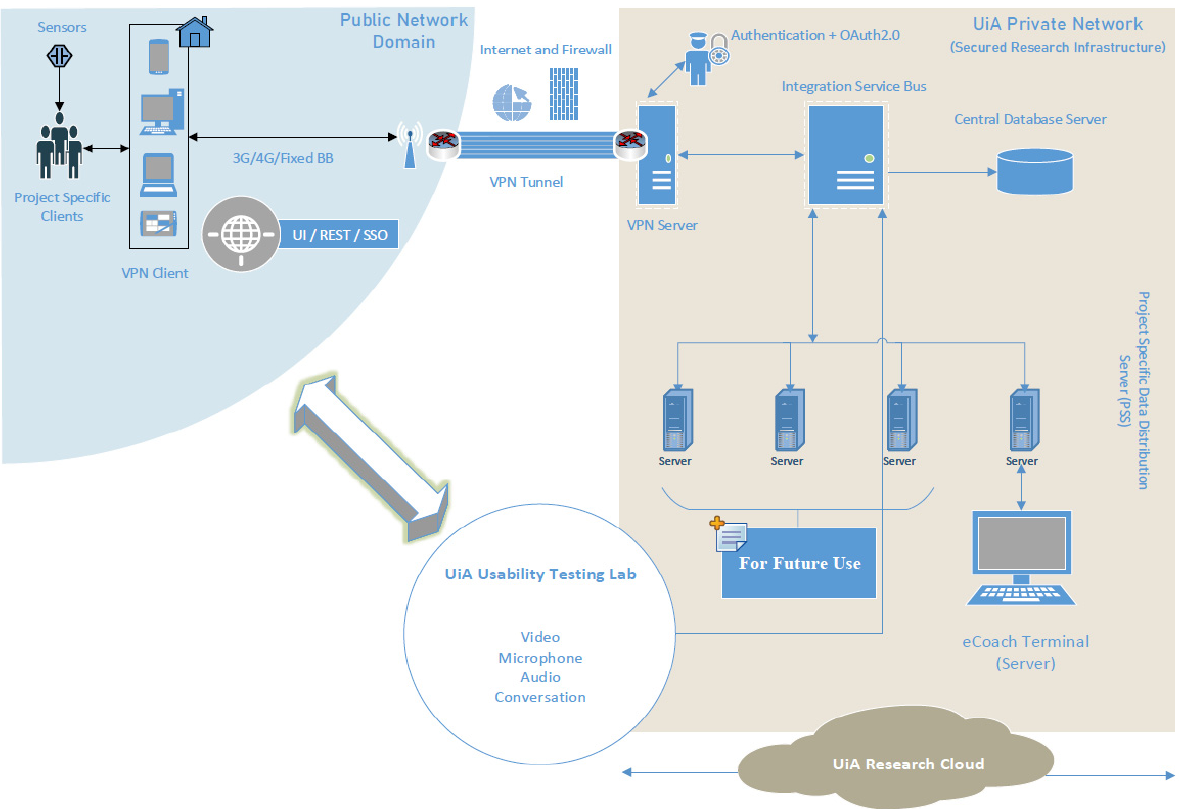
Figure 1. The developed digital infrastructure with extended SSK features.